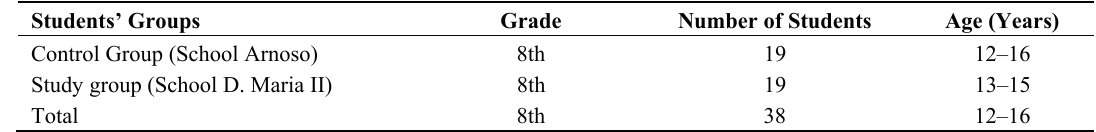
Figure 3. Exploitation of the “scientific gardens” and “scientific lectures”, with the participation of several members from the educational community. Table 1. Characteristics of the study population.